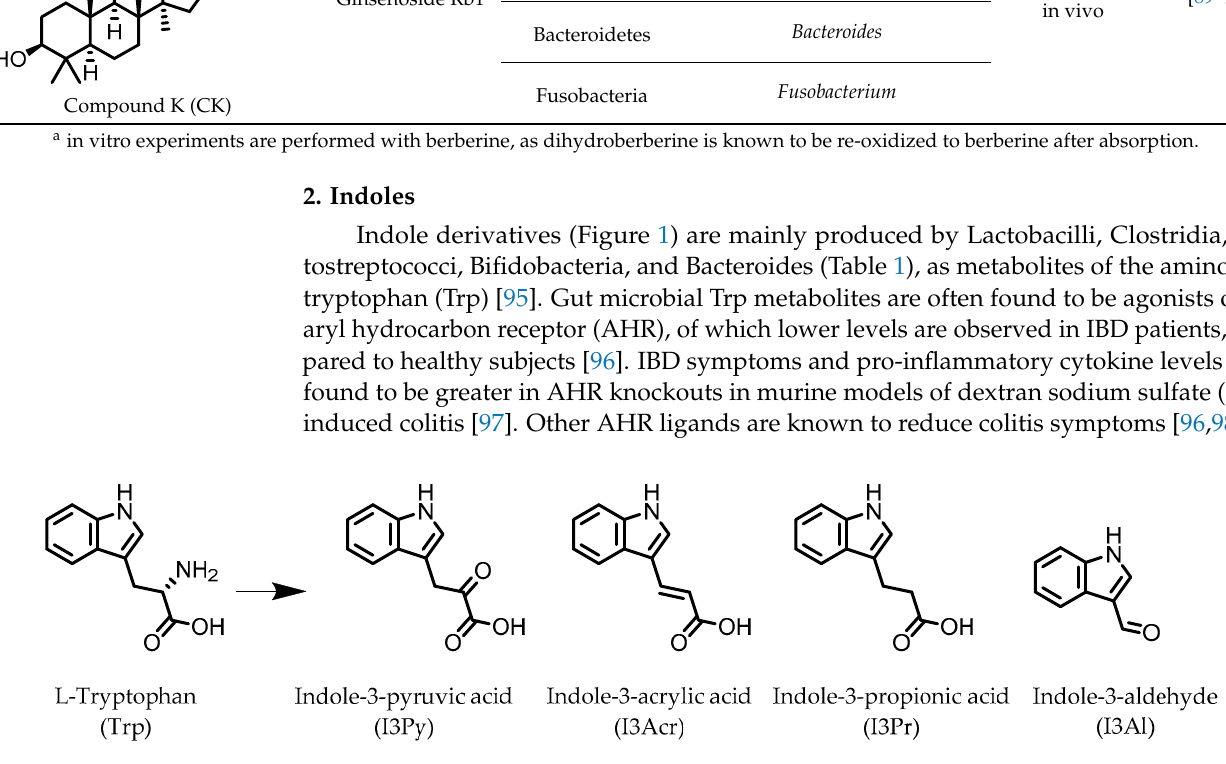
Figure 1. Structures of L-tryptophan and several indole metabolites produced by the gut microbiota. AHR activation by the gut microbial Trp metabolite indole-3-aldehyde (I3Al) was shown to stimulate mucosal lymphocytes to secrete interleukin 22 (IL-22), an anti-inflam- matory cytokine known to play an important role in protecting mice from developing IBD [99]. Increased IL-22 secretion causes signal transducer and activator of transcription 3 (STAT3) phosphorylation, which ultimately leads to faster proliferation of intestinal epi- thelial cells (IECs), contributing to the recovery of damaged intestinal mucosa following DSS-induced colitis [10]. Indole-3-propionic acid (I3Pr) also activates the AHR receptor, which induced IL-10 receptor expression in cultured IECs. Oral administration of I3Pr was shown to improve DSS-induced murine colitis symptoms, which was attributed to increased signaling of the anti-inflammatory cytokine IL-10, due to higher expression of IL-10 receptors [13]. Additionally, I3Pr was found to act as a ligand for the pregnane X receptor (PXR) in vivo, and led to lower TNF- α levels together with higher levels of mRNA coding for tight junction proteins, thus contributing to intestinal integrity. With the help of knockout ex- periments, it was determined that activation of PXR modulates Toll-like receptor 4 (TLR4) signaling, which is known to activate nuclear factor κ B (NF- κ B), a pro-inflammatory tran- scription factor. Accordingly, oral administration of I3Pr could activate PXR in the colon, which prevents lipopolysaccharide (LPS)-induced inflammation via modulation of TLR4, thereby preserving the intestinal integrity [14]. Administration of indole-3-pyruvic acid (I3Py) to mice with CD4 + T cell-induced co- litis led to an increase in the amount of IL-10-producing T cells, while the number of Th1 cells in the mucosa was decreased, resulting in a reduction in colitis symptoms [19]. In a co-culture of murine-derived colonic spheroids and murine bone marrow-de- rived macrophages (BMDMs), indole-3-acrylic acid (I3Acr) promoted IL-10 secretion while suppressing TNF- α production upon stimulation with LPS, via activation of AHR. This stimulated the expression of the mucin protein coding gene, Muc2 , which may help to protect the intestinal epithelium. When human peripheral blood mononuclear cells (PBMCs) were treated with I3Acr, a reduction in IL-1 β and IL-6 was observed, upon LPS stimulation. Moreover, not only was AHR activation reproduced in the human cell line, activation of the anti-inflammatory Nrf2–ARE pathway was observed. Using these human PBMCs in the co-culture, I3Acr treatment promoted important anti-inflammatory and